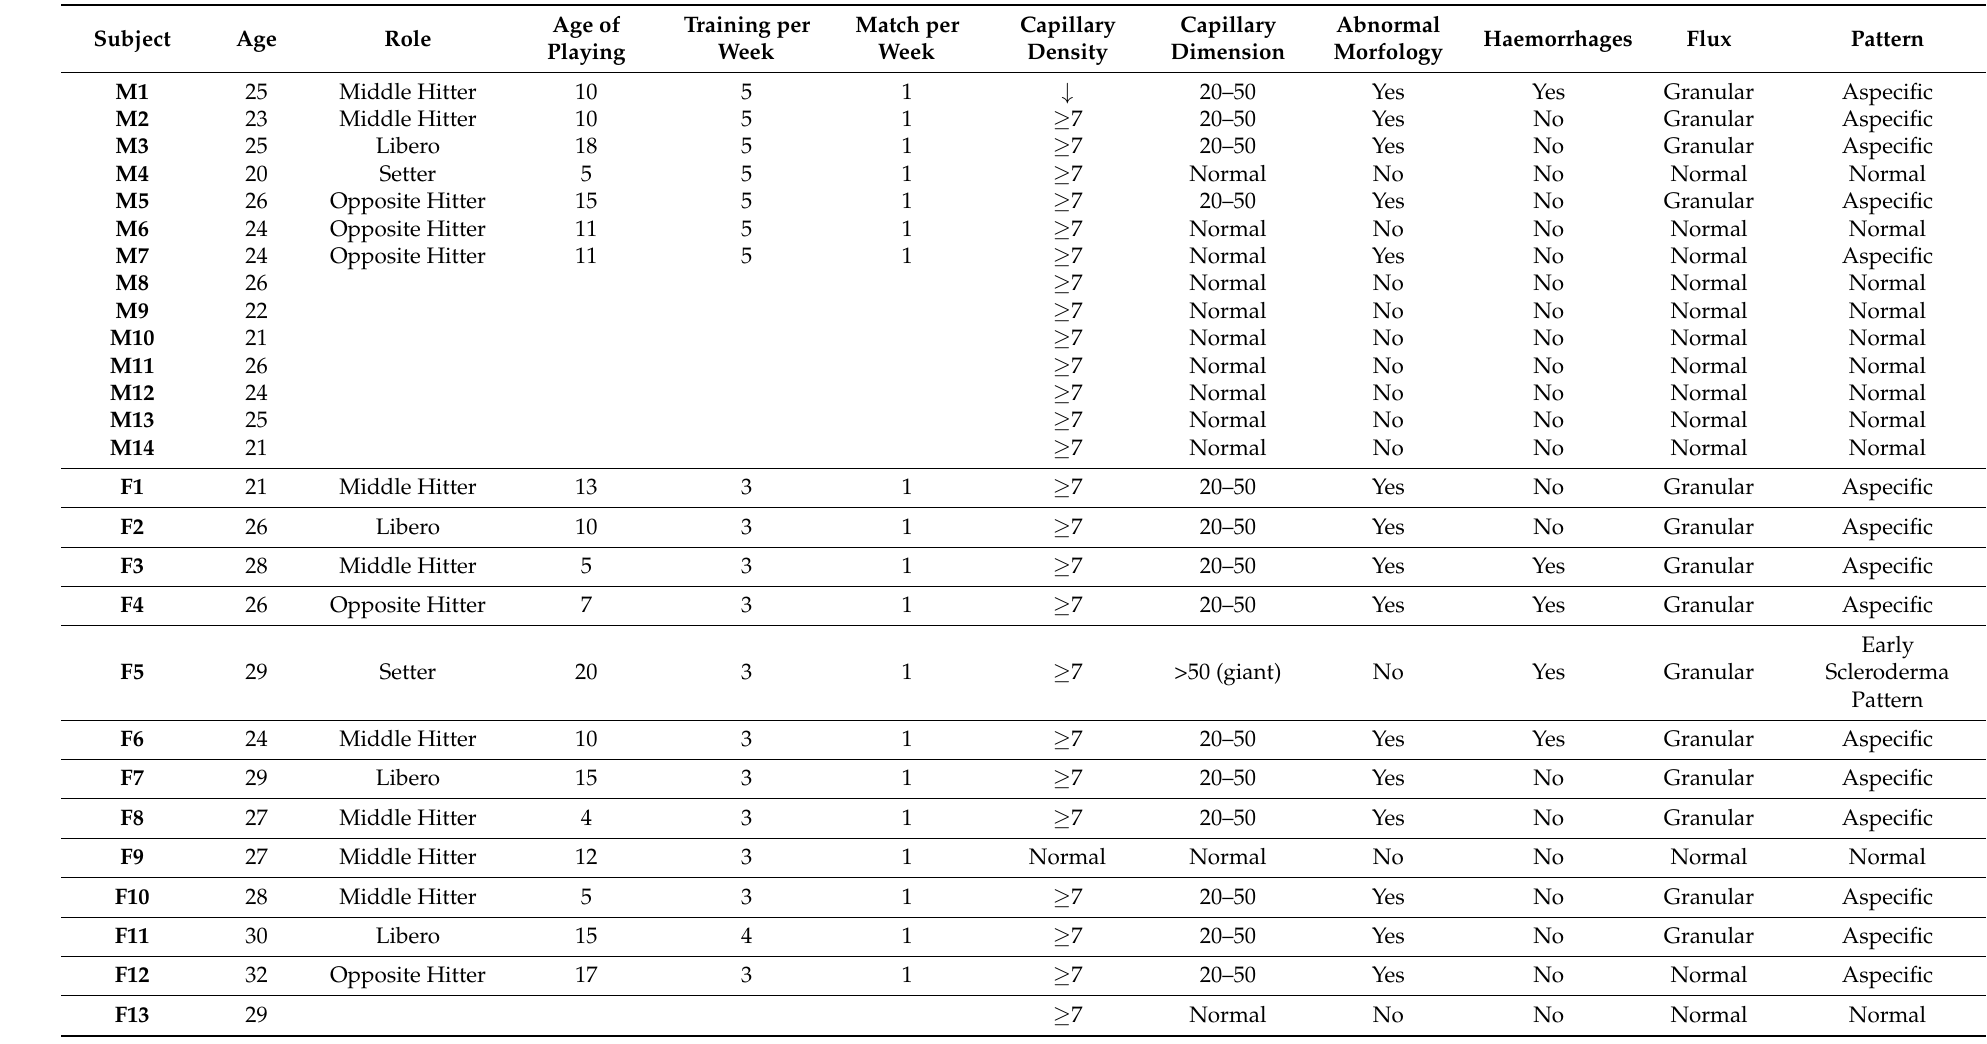
Table 2. Subjects characteristics and capillaroscopic